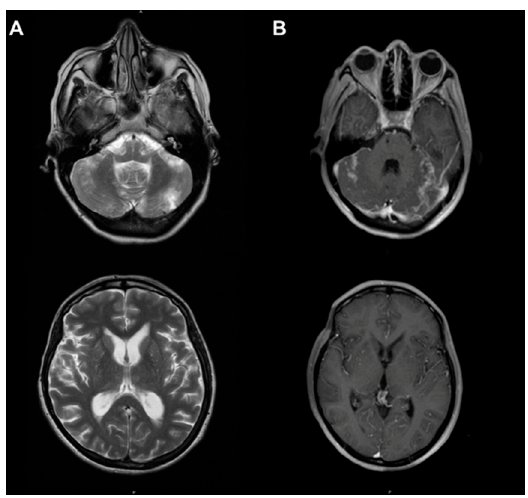
Figure 1. Axial magnetic resonance with contrast. ( A ) T2 sequence: hyperintense bilateral cerebellar lesions and in the right cingulate gyrus. ( B ) T1 with gadolinium: demonstrating gadolinium uptake in the posterior cranial fossa.